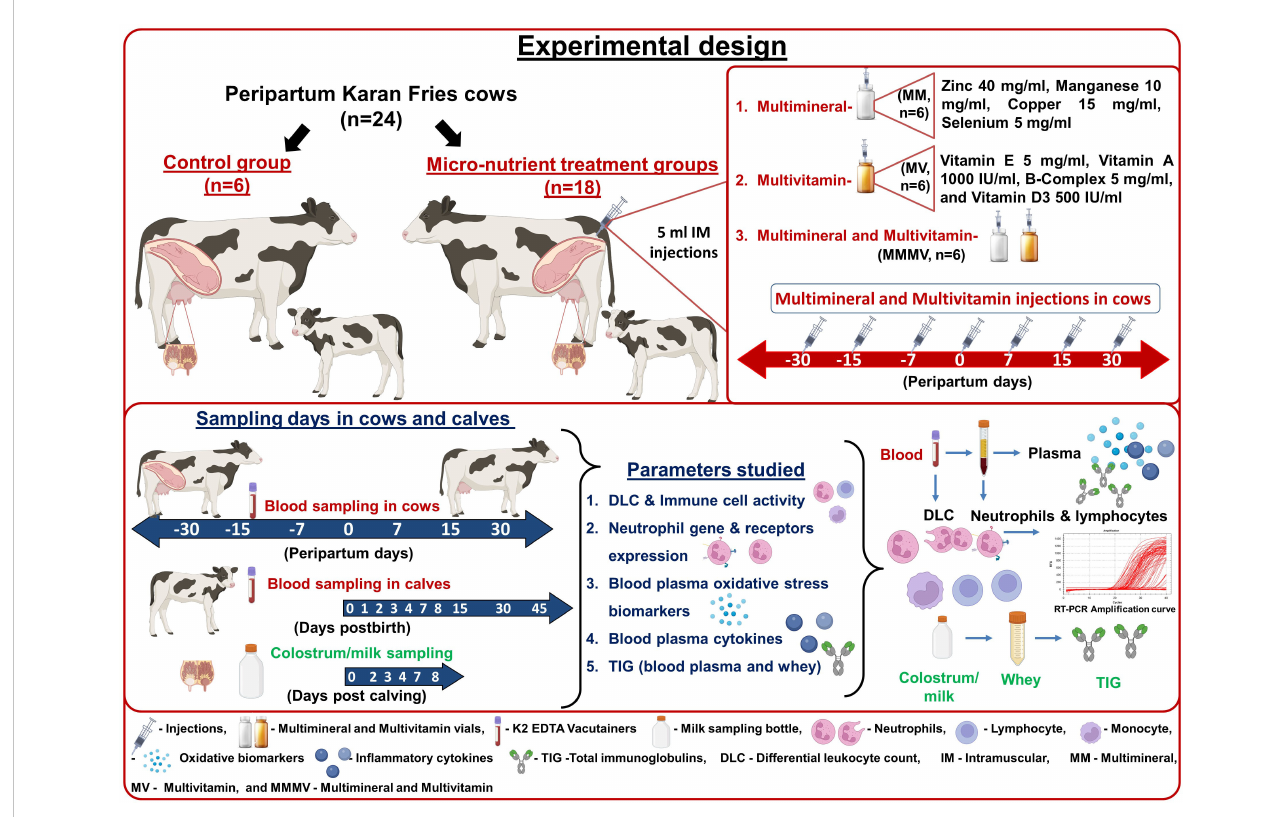
FIGURE 1 Schematic representation of the experimental design with the treatment of the transition dairy cows, the samples collected, and the parameters